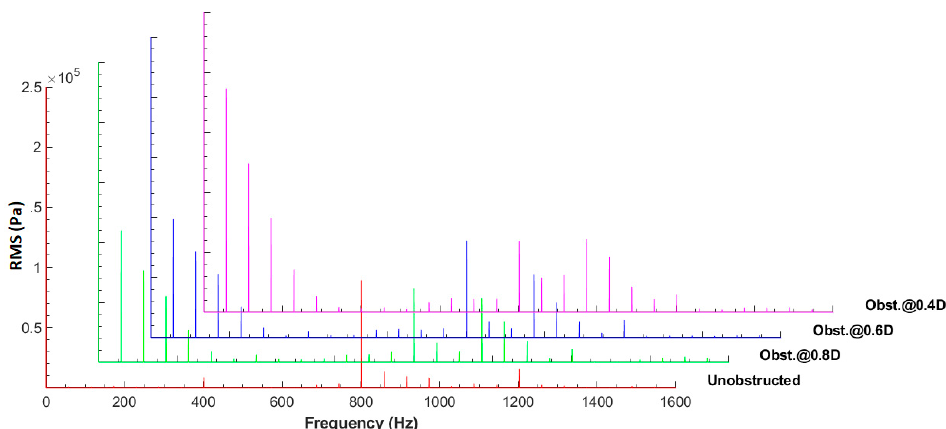
Figure 15. Frequency spectra in the rotating reference frame (monitor point R1) for different rotor blockage sizes.